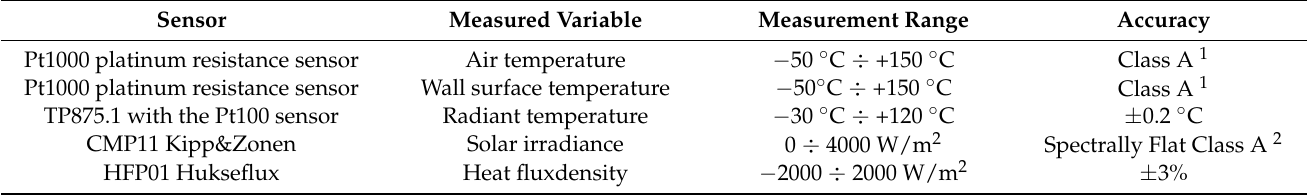
Table 1. The main metrological parameters of the measuring sensors used. Sensor